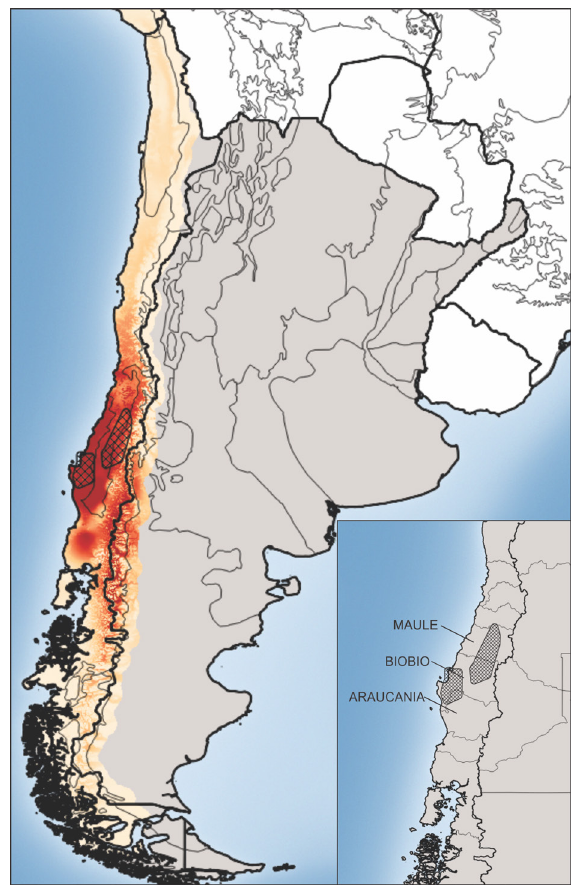
Figure 5. Cross-hatching indicates areas where the chances of finding N. chilensis are higher. In the smaller political map are indicated the Regions where these areas are